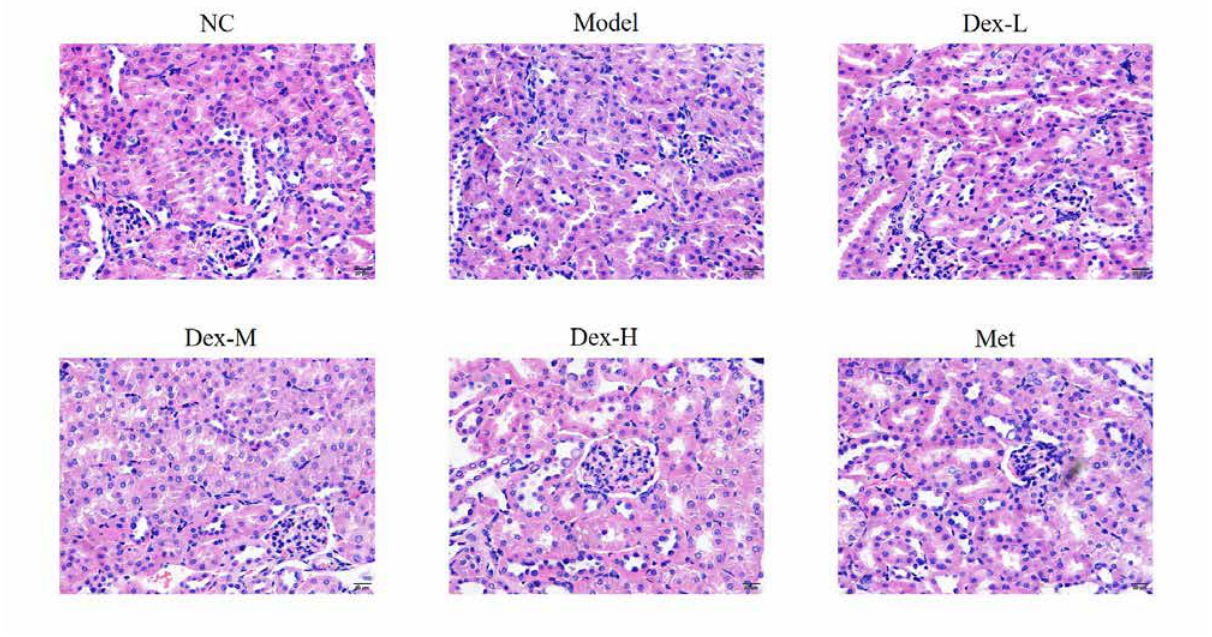
Figure 1: The Pathology of different groups in kidney tissues by HE staining (400×) NC: normal control group; Model: DN model group; Dex-L: Dex low-dose treated group; Dex-M: Dex medium-dose treated group; Dex-H: Dex high-dose treated group; Met: Metformin treated group